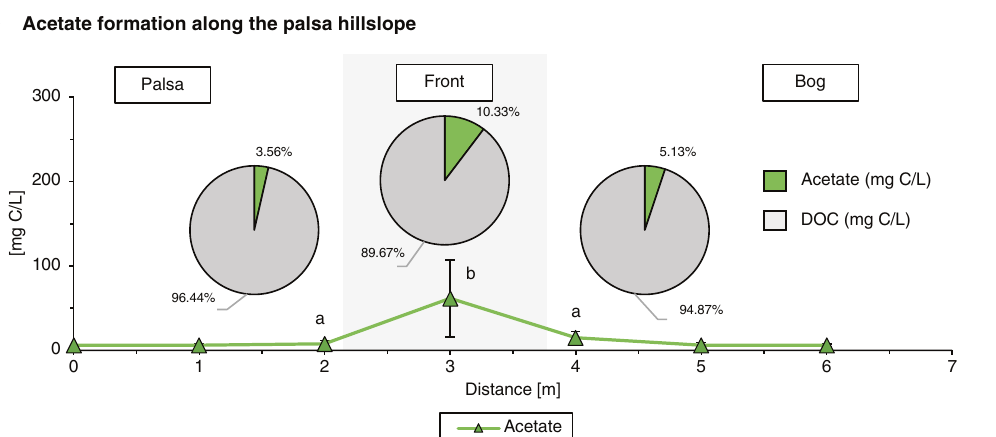
Fig. 4 Bioavailability of reactive iron (Fe)-associated organic carbon (OC) inferred from dissolved organic carbon (DOC) oxidation state and composition. a Composition of OC associated with reactive Fe minerals and OC released into the porewater. Fe-bound carbon in palsa soils, underlain by intact permafrost, is comprised of more aliphatic species (class 1, green) and more aromatic species (class 2, purple). This is lost with reductive dissolution into the porewater. Towards the collapsing front into the bog, the remaining OC associated with reactive Fe minerals fraction (purple) is comprised of less bioavailable organic compounds which are likely associated with clay minerals (common in Palsa A, Front and Bog). DOC, which is only found in Palsa A, is enriched in more aliphatic compounds (green). Towards Front and Bog, only more aromatic species (purple) remain (Supplementary Figs. S17 – S19, Supplementary Table S5). b Redox properties and molecular weight of released organic carbon into the porewater along the palsa hillslope (Supplementary Fig. S20). Reported values and error bars represent the average and the range of duplicate porewater analysis along two palsa hillslopes (Supplementary Figs. S1 and S4). c Acetate formation along the palsa hillslope. Following further decomposition of the DOC, highly bioavailable acetate [mg C L − 1 ] is formed which then is again used to further reduce present reactive Fe(III) minerals to Fe 2 + coupled to acetate oxidation and CO 2 formation. Reported values and error bars represent the average and standard deviation of 8 palsa to bog hillslopes, sampled in June/July 2019 (Supplementary. Figs. S1 and S4). Different small letters above data mean signi fi cant differences ( P < 0.05, one-way ANOVA: TukeyHSD